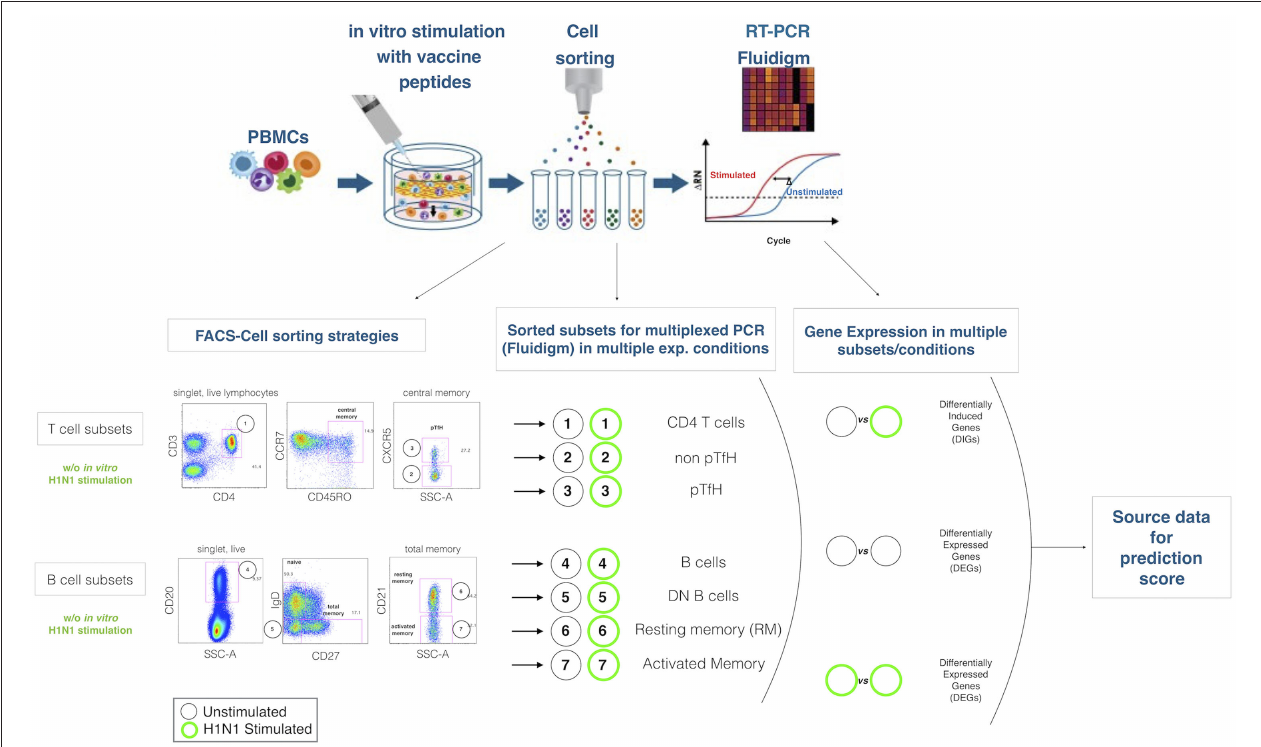
FIGURE 1 | Experimental design. The cartoon on the top panel depicts the experimental procedure. Briefly, total PBMCs are in 2 aliquotes, one stimulated and the latter unstimulated. After sorting lymphocite subsets, gene expression is analyzed by Fluidigm Biomark. Bottom panel describes the gating strategies and the lymphocites subsets selected for sorting and gene expression analysis. Mathematical analysis applied on the subsets in order to obtain differentially expressed genes (DEGs) and differentially induced genes (DIGs) are described.